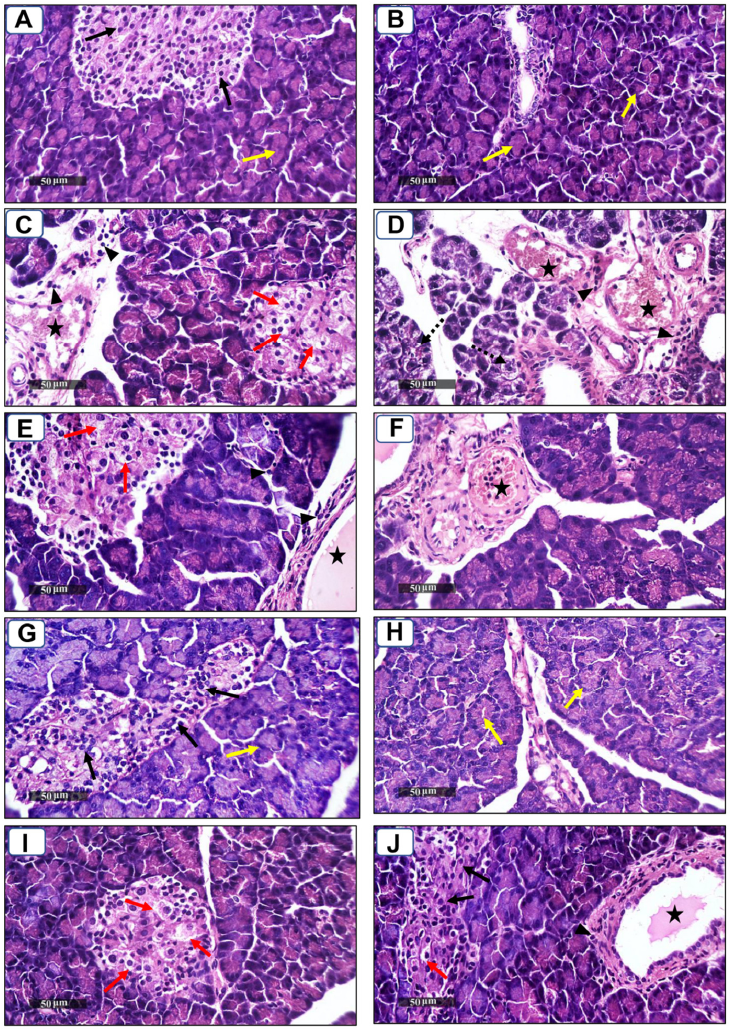
Figure 1. Photomicrograph sections of pancreases from control and diabetic rats with or without treatments. Group I (control) ( A , B ) showed normal organized pancreatic parenchyma with apparent intact pancreatic islets (black arrow), intact pancreatic acini (yellow arrow); group II (diabetic) ( C , D ) showed moderate swelling and vacuolar degenerative changes in pancreatic islets beta cells (red arrow), marked congested and dilated interlobular blood vessels (star). Mild records of perivascular inflammatory cells (arrow head) were shown with focal records of degenerated pancreatic acini (dashed arrow); group III (50 mg/kg, cichoriin) ( E , F ) showed almost the same persistent records as diabetic samples, group IV (100 mg/kg, cichoriin) ( G , H ) showed minimal records of cellular swelling and degenerative changes all over pancreatic islets (black arrow) or acini (yellow arrow), and group V (5 mg/kg, GB)) ( I , J ) showed persistent records of degenerative changes of some pancreatic islets (red arrow) alternated with almost apparent intact islets with intact subcellular details (black arrow), and congested/dilated BVs (star) with mild inflammatory cells infiltrates were shown (arrow head). Scale bar = 50 µ m (400 ×